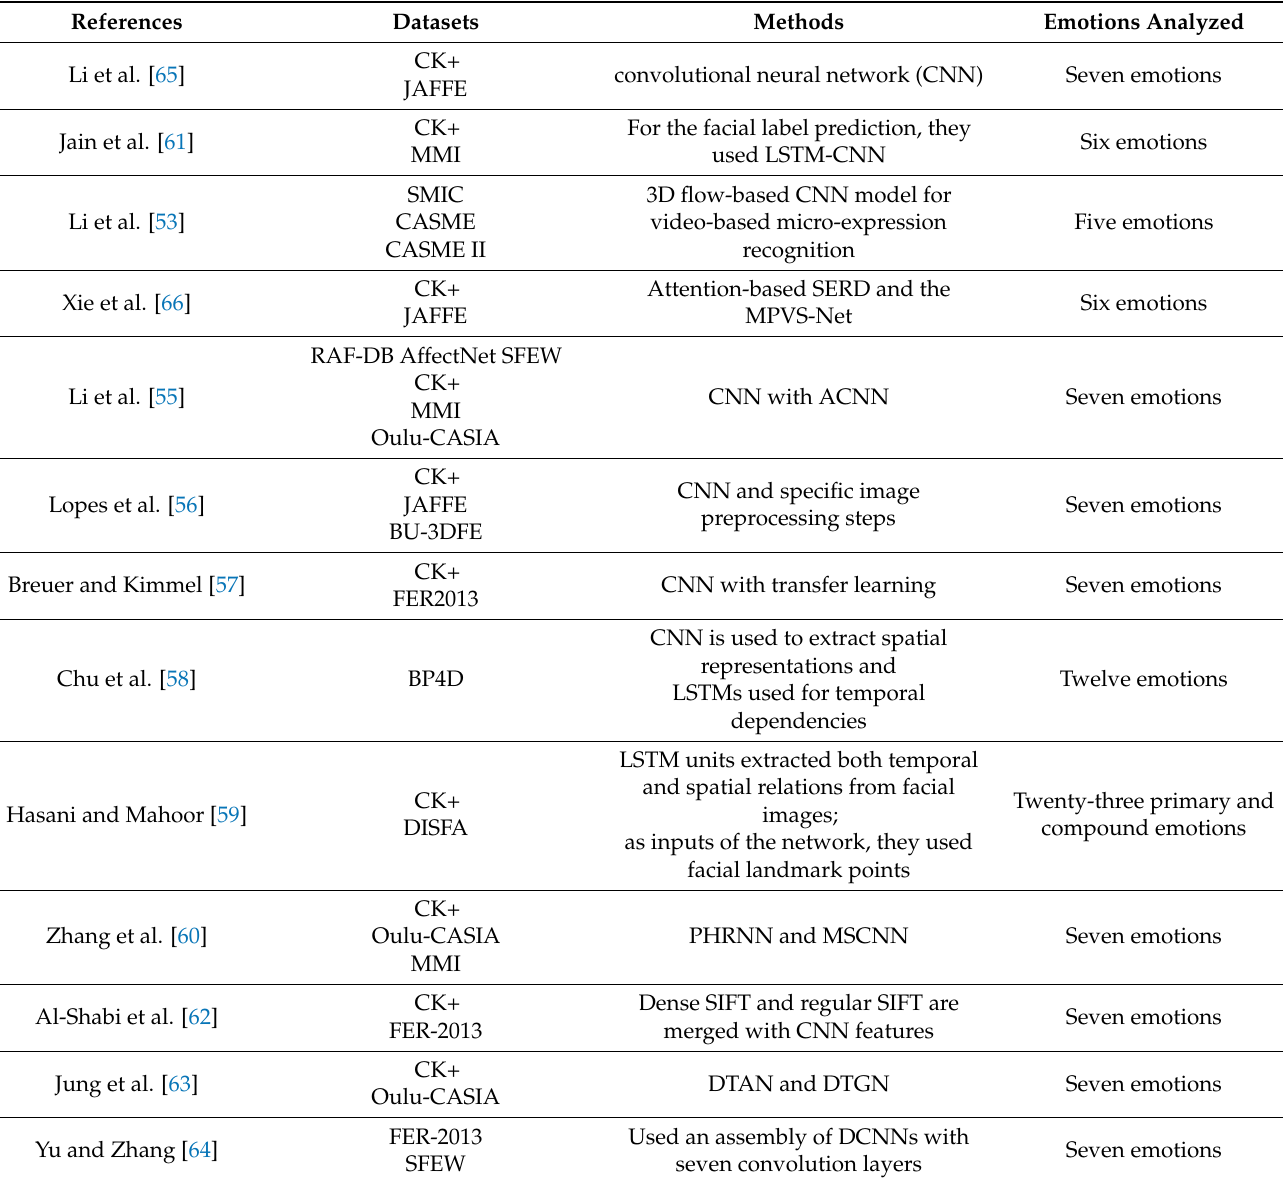
Table 2. Deep learning-based approaches for